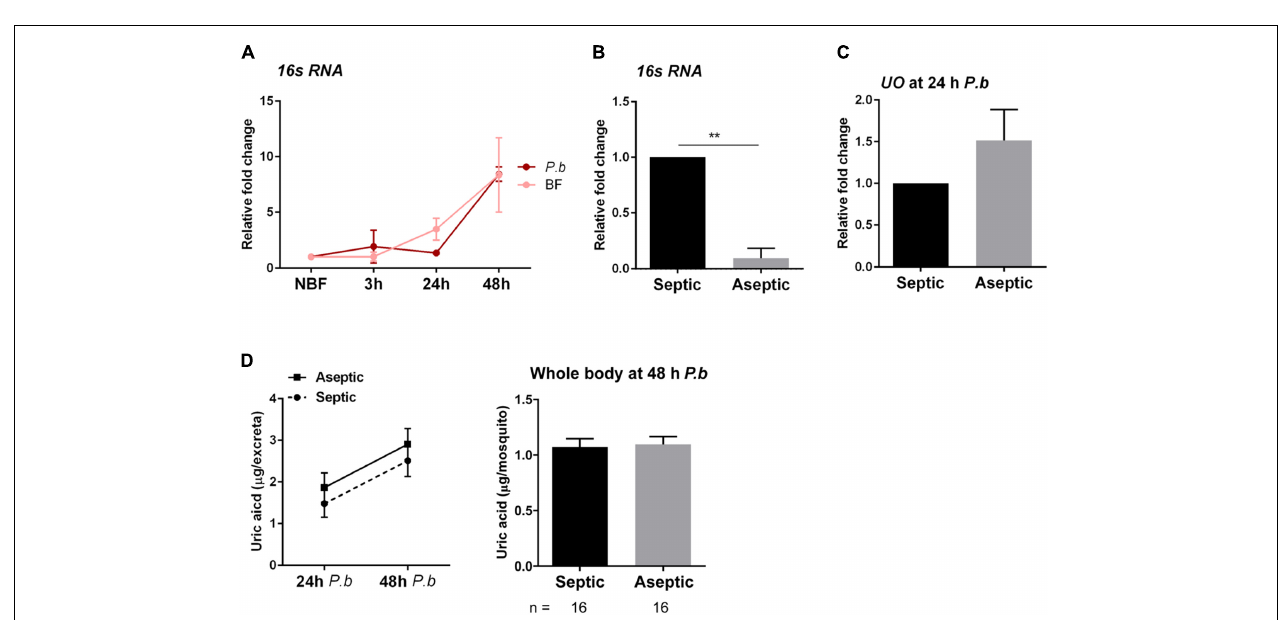
FIGURE 4 | The mosquito microbiota does not influence uric acid production. The impacts of blood-feeding and P. berghei infection on the mosquito microbiome were analyzed in whole mosquitoes by the relative quantification of bacterial 16s rRNA via qRT-PCR (A) . Mosquitoes were examined from sugar-fed (NBF) conditions or 3, 24, and 48 h after feeding on a naïve or P. berghei -infected blood meal. To determine the contribution of the mosquito microbiota to the metabolism of uric acid, mosquitoes were treated with antibiotics in 10% sucrose for 3 days (aseptic), and compared to mosquitoes maintained on 10% sucrose alone (septic) through the relative quantification of bacterial 16s rRNA (B) . The reduction of microbiota levels did not influence urate oxidase ( UO ) expression (C) , or the production of uric acid (D) , measured in both the excreta and the whole mosquito. For all experiments, data were from three independent experiments and displayed as the mean ± SEM. Data examining the 16s rRNA levels (A) and uric acid in excreta (D) were analyzed using a two-way repeated-measures ANOVA followed by a Sidak’s multiple comparison test, while an unpaired t -test was used for all other experiments to determine significance. Asterisks denote significance (** P < 0.01). n, number of individual mosquitoes examined. Data analysis was performed using GraphPad Prism